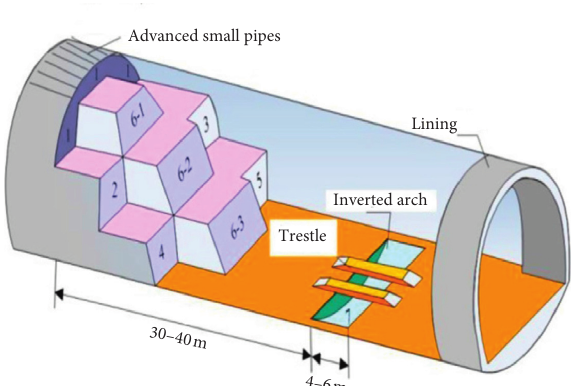
Figure 7: Longitudinal perspective of TSEM